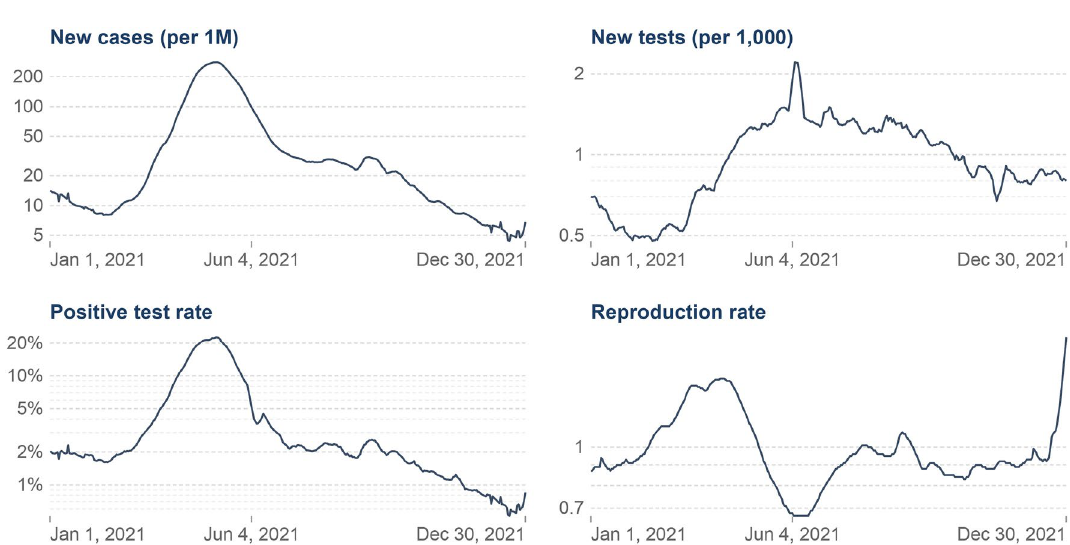
Figure 3. Graphical visualization of Covid-19 cases, the report contains a record of new case, new taste case, positive rate, reproduction rate, and over the